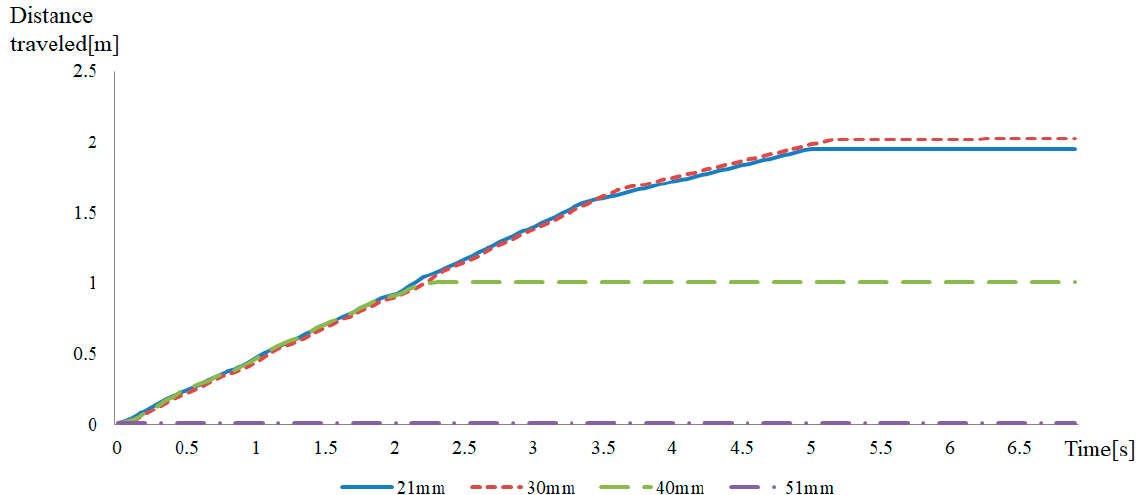
Figure 15. Experiment results (blue straight line: distance traveled versus time when crossing a 21 mm obstacle, red dot line: distance traveled versus time when crossing a 30 mm obstacle, green long dot line: distance traveled versus time when crossing a 40 mm obstacle, and purple dash-dotted line: distance traveled versus time when crossing a 50 mm obstacle).